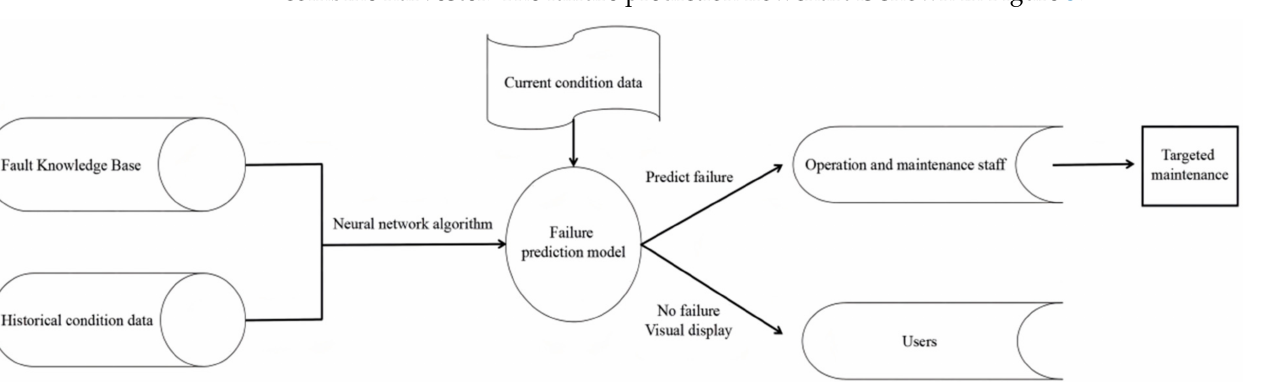
Figure 5. Failure prediction